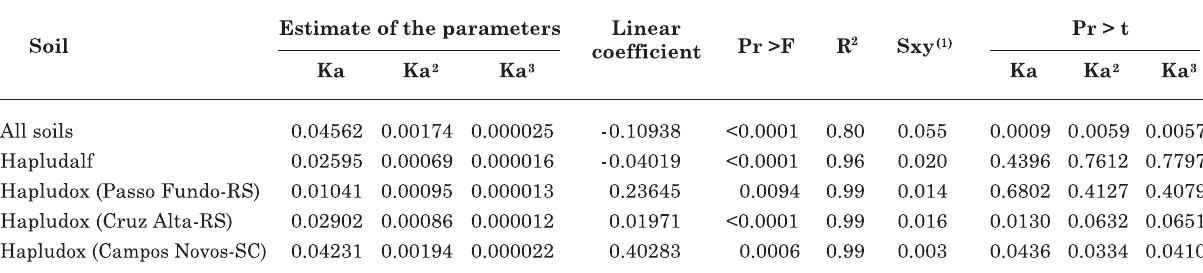
Table 3. Analysis of variance for the polynomial models